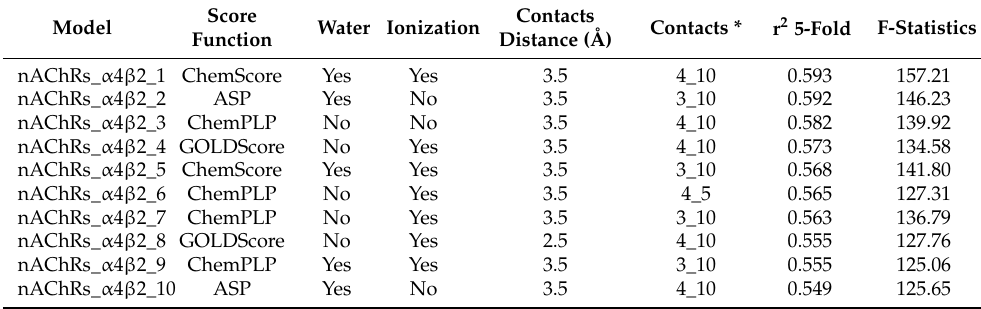
Table 1. The critical contacts according to the two best models are listed in Table 2. Table 1. Docking conditions and statistics for the 10 best dbCICA models for ( α 4) 2 ( β 2) 3 receptor. Score Model Function